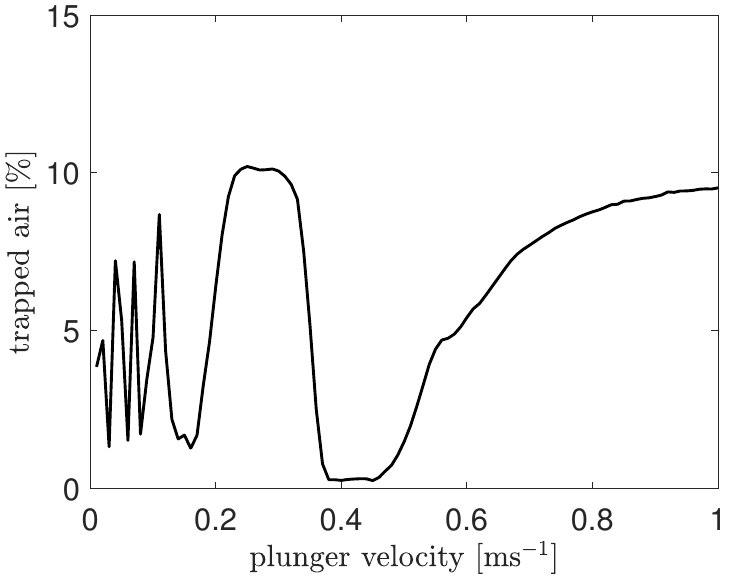
Figure 6. Fraction of trapped air inside the shot sleeve for slow-stage velocities between 0 and 1 ms − 1 ; parameters according to Table